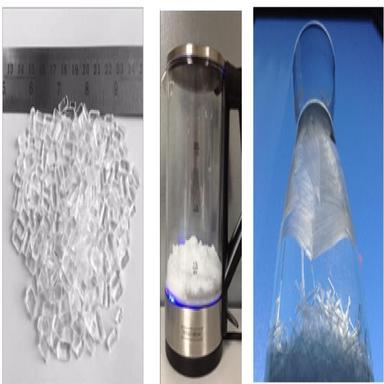
Crystals of the STP (left), melting the crystals by heating (center), the crystallization of the salt solution in a glass flacon (right).